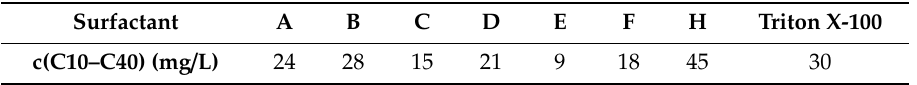
Table 5. Aqueous solubility of kerosene (C10–C40) in solutions of the di ff erent surfactants (500 mg / L).